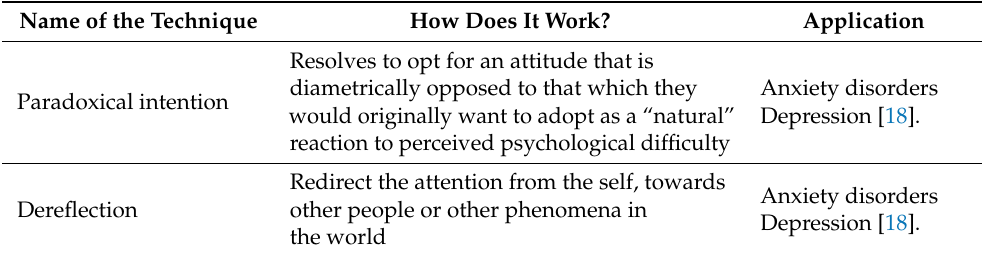
Table 1. Techniques of existential psychotherapy. Name of the